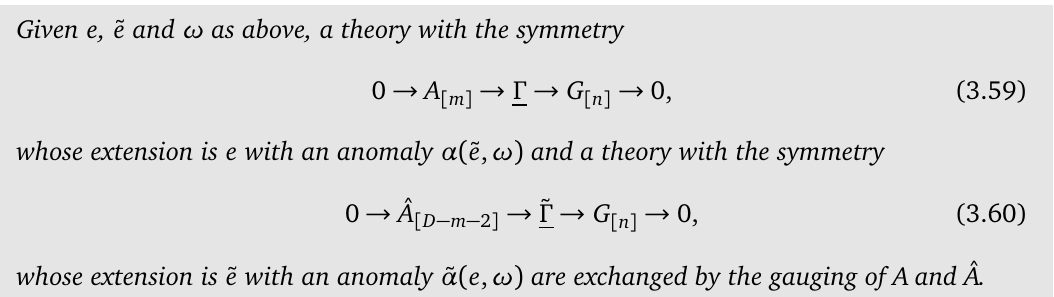
Figure 7: A curious skein relation in a 3d theory. Here a thik line represents a (cid:90) which is a boundary of a (cid:90) a minus